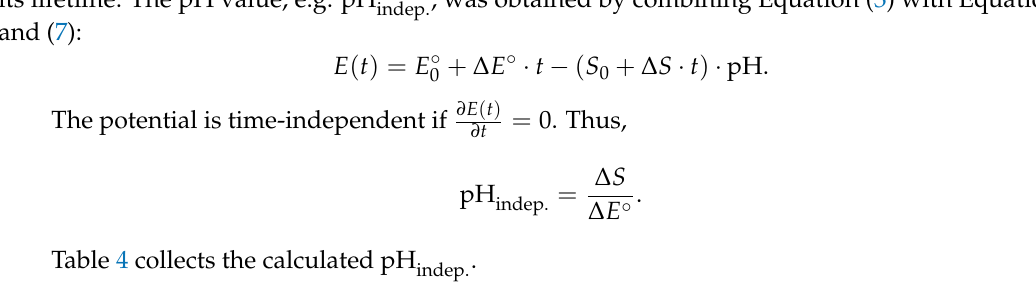
Table 4. Values of pH for which the electrode potential is independent of its